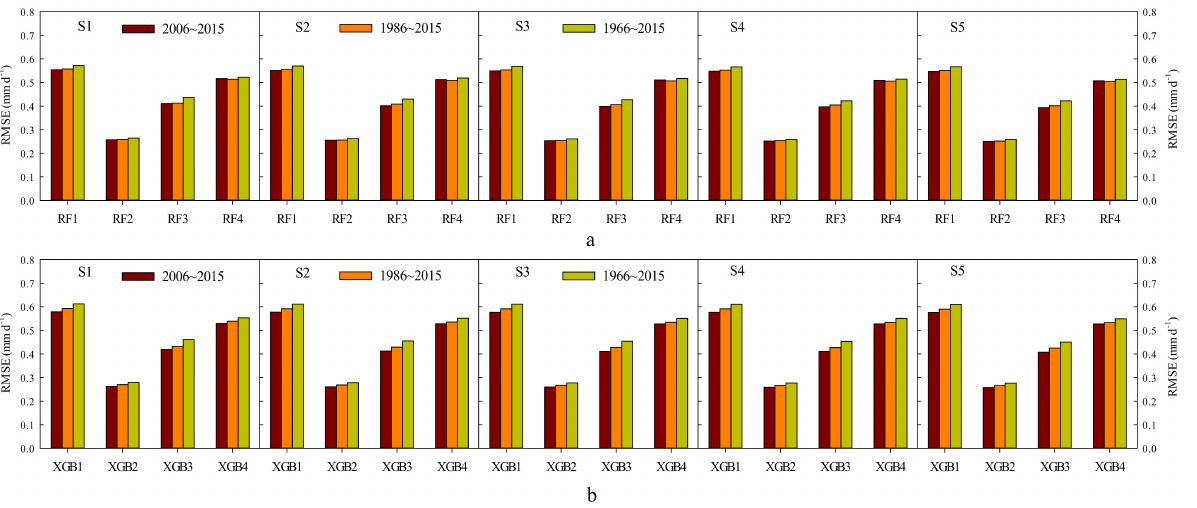
Figure 6. Bar plots of average RMSE values of the models for estimating daily ET 0 by various length of years using the different proportions in the testing stage at the 21 weather stations. ( a , b ) stand for RF and XGBoost, respectively; S1, S2, S3, S4, and S5 represent data splitting proportions of 5:5, 6:4, 7:3, 8:2, and 9:1, respectively. RF1, RF2, RF3, and RF4 represent the four combinations of the random forest model; XGB1, XGB2, XGB3, and XGB4 represent the four combinations of the extreme gradient boosting model. Table 7. Average statistical values of five proportions of different input parameters of two machine learning models